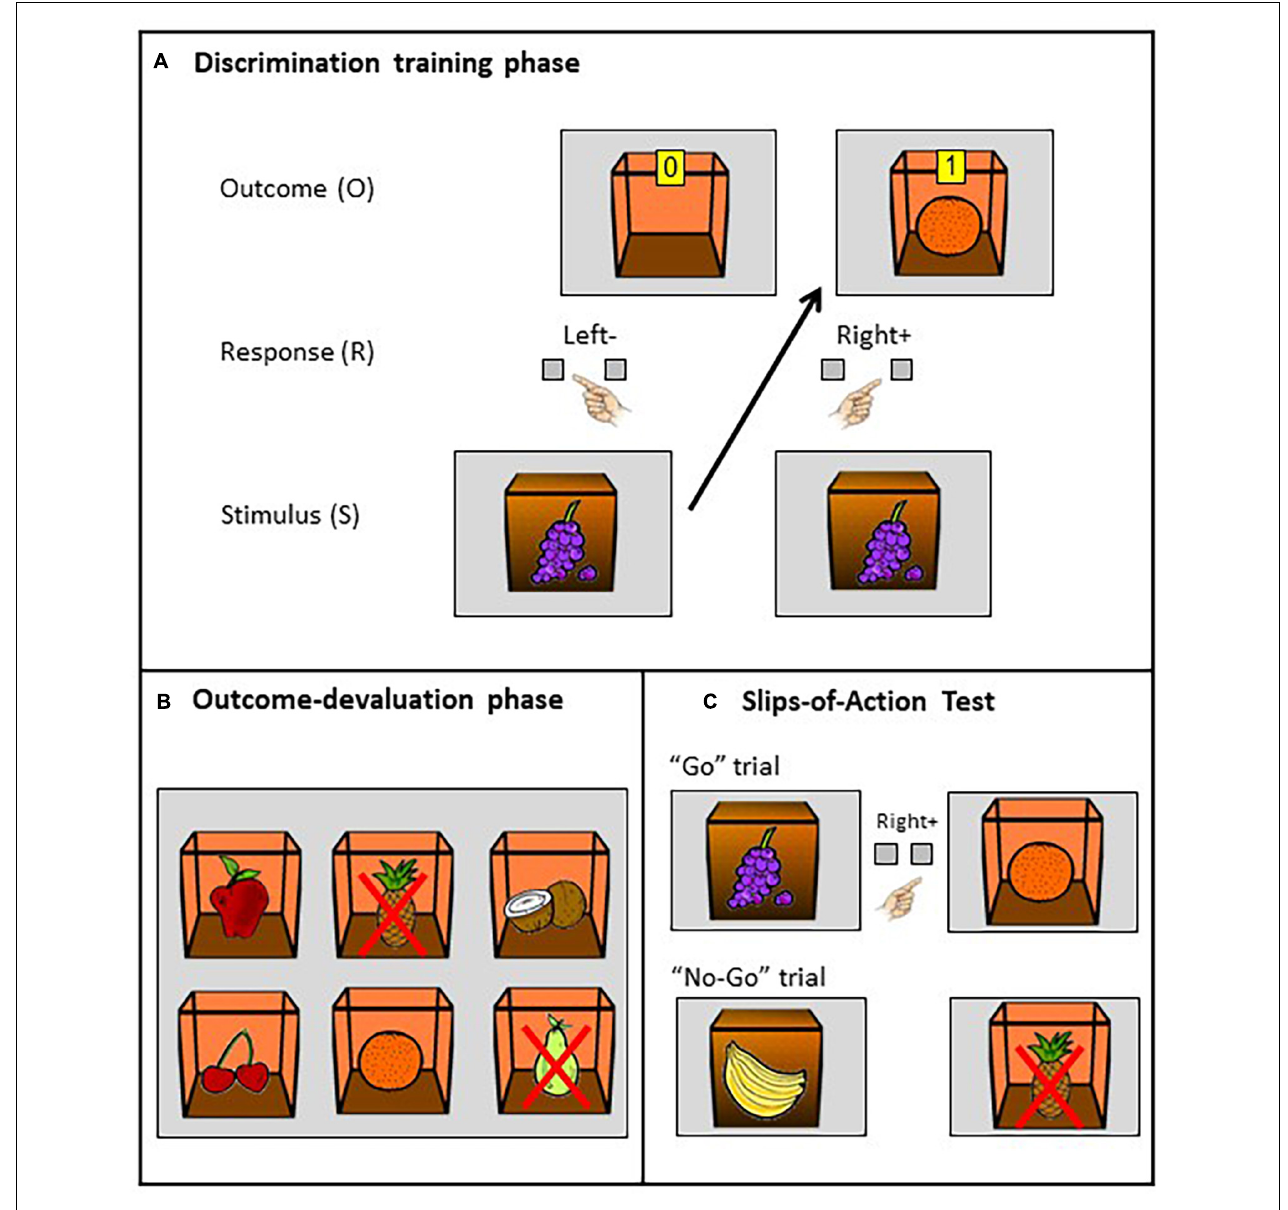
FIGURE 1 | Example of a trial in the SOAT. Explanation of SOAT based on one example configuration. (A) Discrimination training phase: pressing the right key (response, R) when a grape cue (stimulus, S) was presented on the closed box led to successfully opening it, earning points (marked on a yellow square with the number 1) and obtaining an orange (outcome, O) as a reward. On the contrary, pressing the left key led to no points (0 on the yellow square) and an empty reward box. Acoustic and visual feedback was given for correct and wrong answers, which enabled participants to learn the S-R-O associations. (B) Outcome devaluation phase: at the beginning of each block of trials, all the existing fruit outcomes (six in total) were briefly shown together, with two of them being devalued and therefore no longer worthy of points (crossed out in red; in this example, pineapple on top row center and pear on bottom row right), indicating that the response leading to these outcomes will now result in subtraction of points; the other four outcomes (apple, coconut, cherry, orange) remained non-devalued. (C) Slips-of-Action Test: fruit stimuli on closed boxes were rapidly shown one by one. Participants had to press the correct key when the corresponding outcome had not been devalued. The accurate response in this example would be pressing the right key to obtain an orange outcome upon presentation of a grape stimulus (“go” trial). However, upon presentation of the banana stimulus (linked to pineapple: devalued outcome), participants should withhold their response (“no-go” trial). No feedback was given at this stage. Image adapted from de Wit et al. (2012b) and Sjoerds et al. (2016) (obtained with permission).